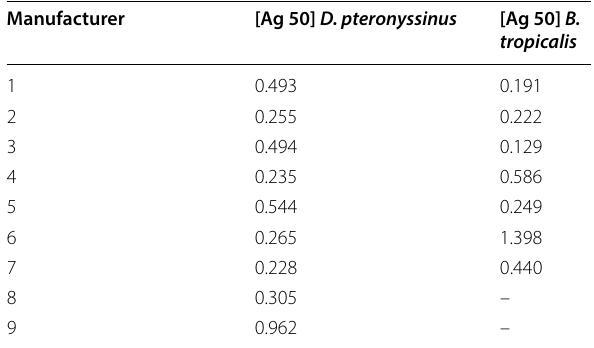
Table 3 Biological potency (Ag50) of commercial extracts ( D. pteronyssinus and B. tropicalis ) from manufacturers 1 to